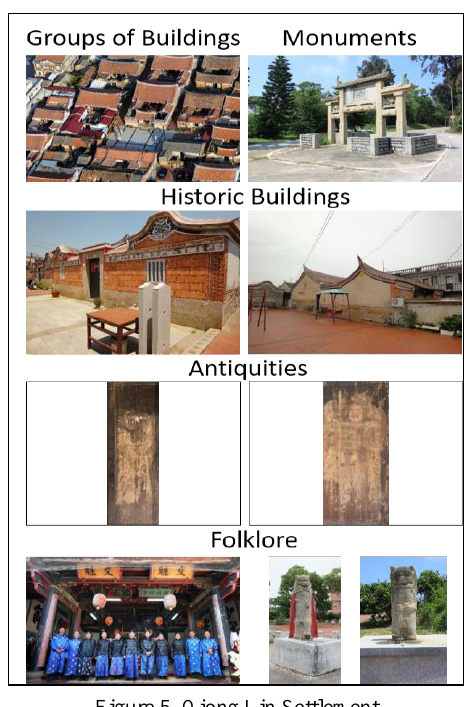
Figure 5. Qiong Lin